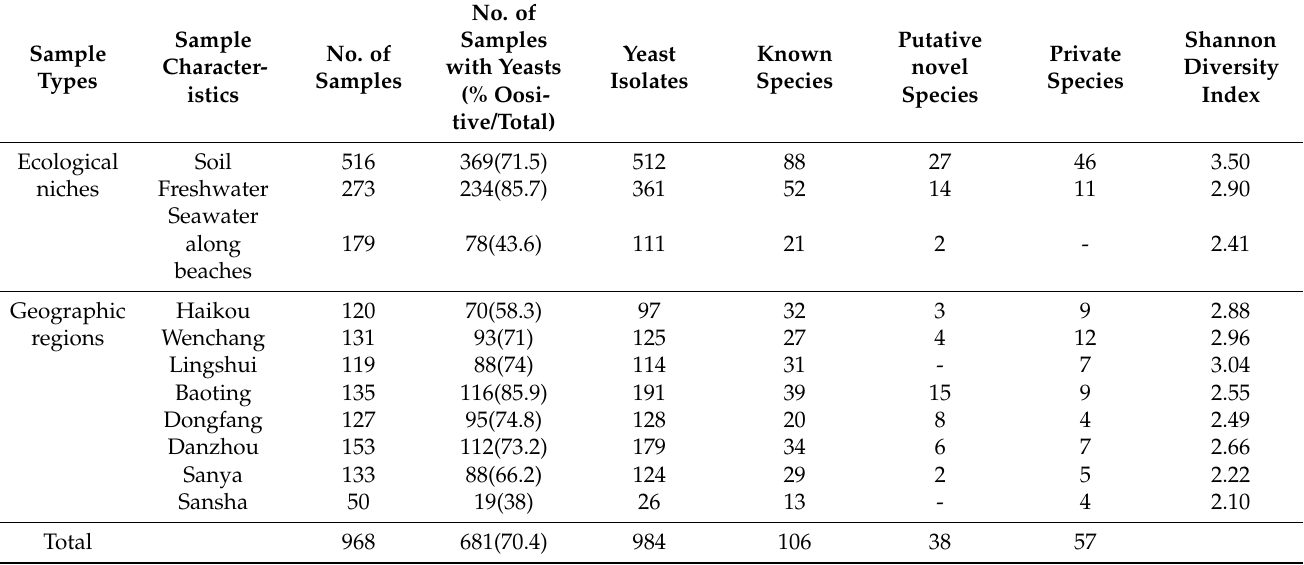
Table 1. Summary statistics of yeast isolation from Hainan environment